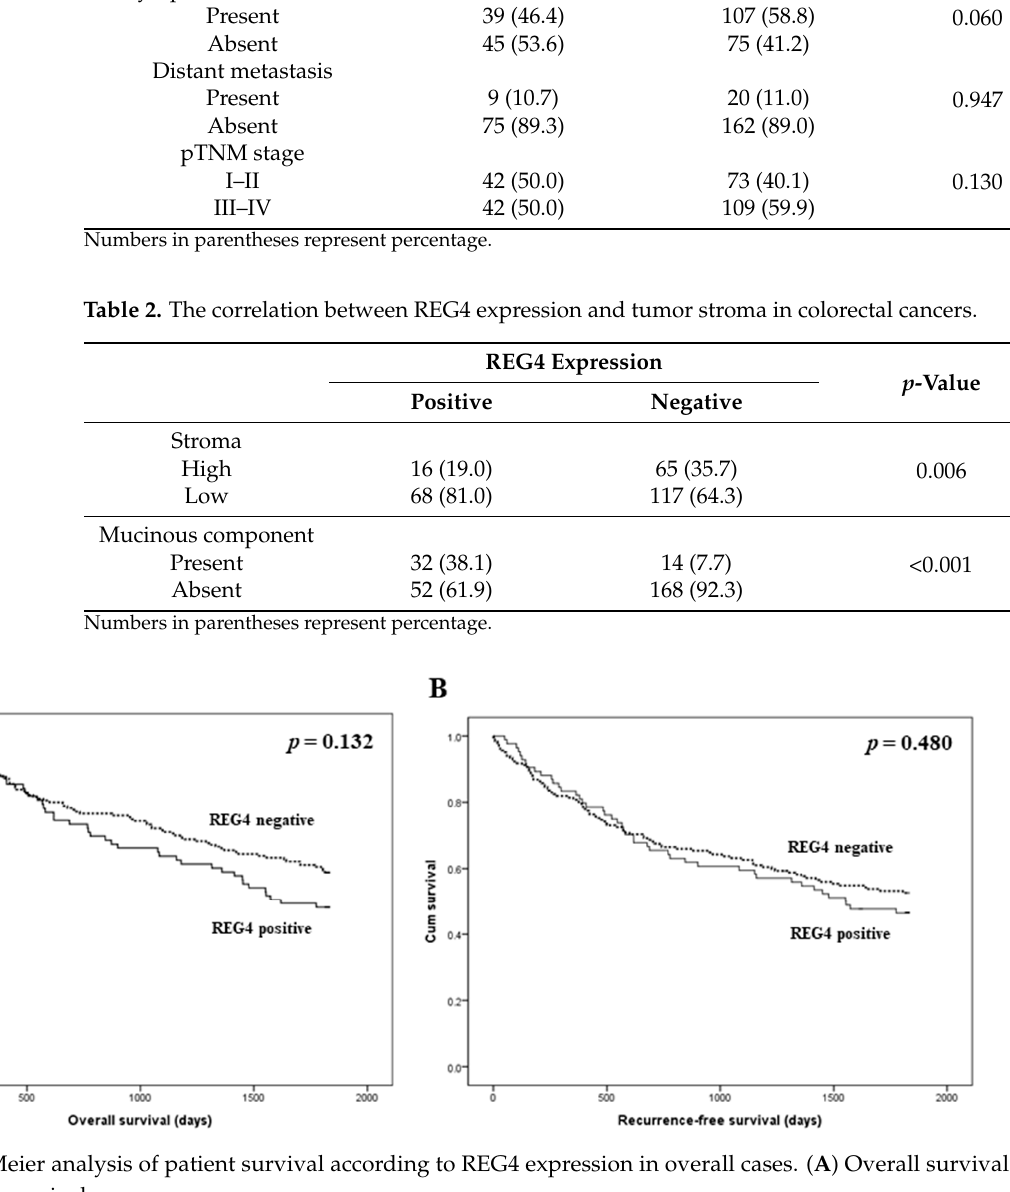
Figure 3. Kaplan-Meier analysis of patient survival according to REG4 expression and intratumoral stroma in colorectal cancer. ( A , B ) Overall and recurrence-free survival according to REG4 expression in colorectal cancer cases with high stroma. ( C , D ) Overall and recurrence-free survival according to REG4 expression in colorectal cancer cases with low stroma.